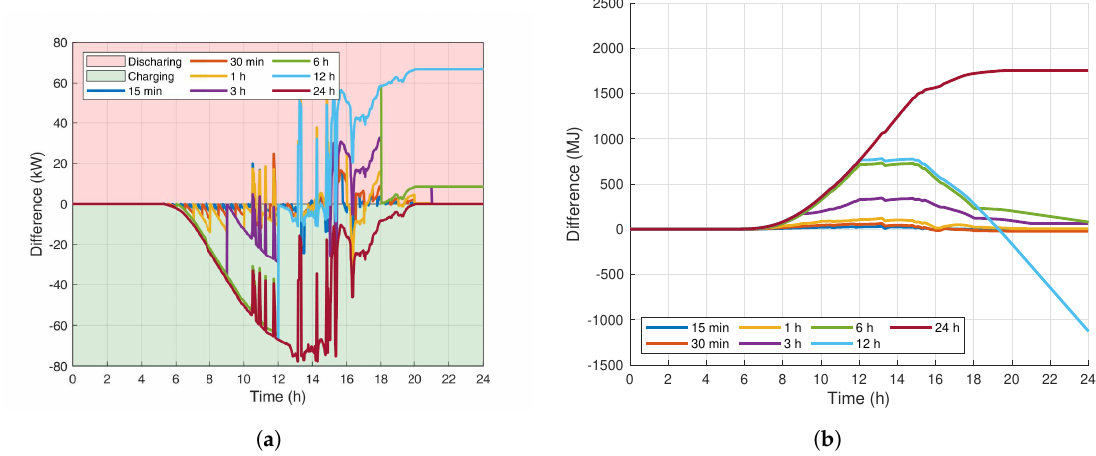
Figure A3. The resulting PV power and energy forecast differences that arise from the use of temperature and solar irradiance forecast when compared to the known truth atmospheric time series of the renewable asset assuming MPPT for the monsoon sky conditions. ( a ) The monsoon sky PV power forecast differences. ( b ) The monsoon sky PV energy forecast differences.